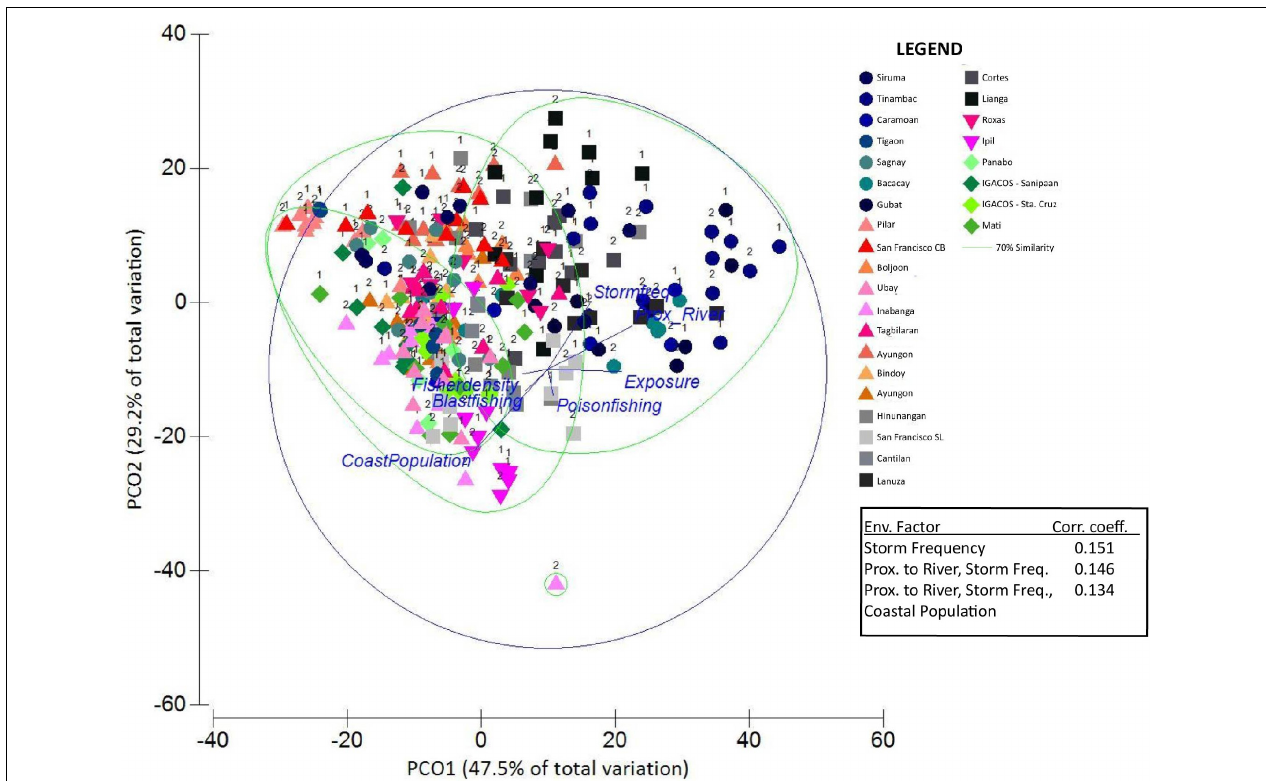
FIGURE 5 | PCO Plot showing the distances between the locations according to differences in the multivariate benthic cover, with vectors depicting Spearman correlation with the environmental factors. 1, inside MPA; 2, outside